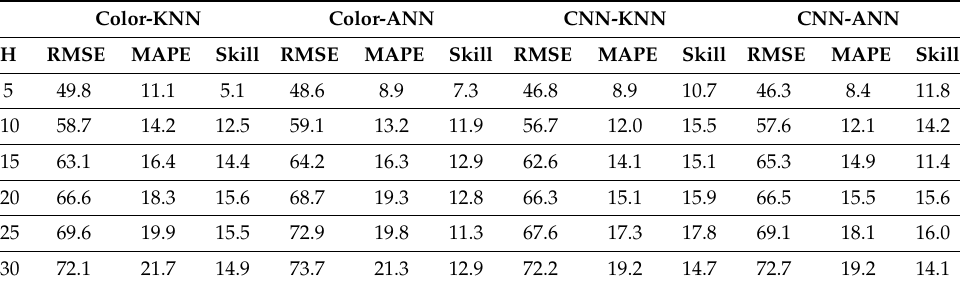
Table 6. Forecasting results comparison among different methods based on RMSE (W/m 2 ), MAPE (%), and Skill score (%). H means forecasting horizons and results are shown in different horizon